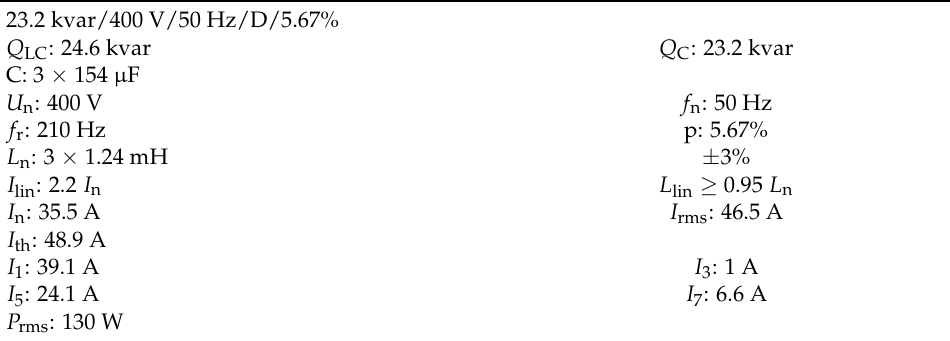
Table A4. Reactor rated data, stages 6 and